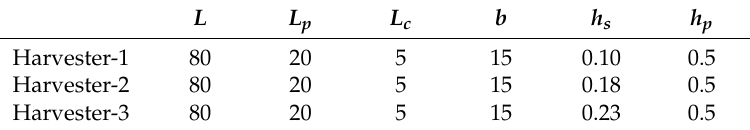
Table 1. Geometrical parameters (mm).